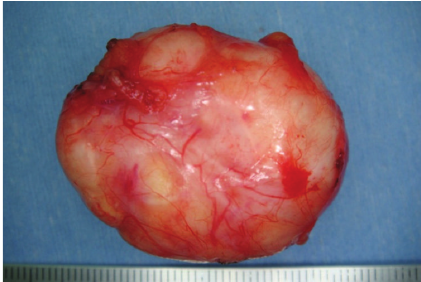
Figure 1: Facial view at the first visit. A mass measuring 4.0 × 3.5cm was evident in the right submandibular region. This photograph is published with the patient’s consent.